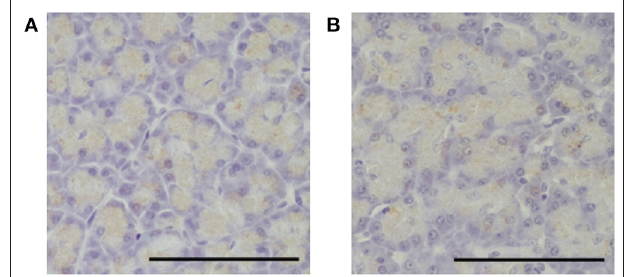
FIGURE 5 | Immunohistochemical image of the pancreas in the pimobendan group. A trypsinogen positive reaction of the zymogen granules was observed in the pancreatic acinar cells both before initiating rapid ventricular pacing (baseline) and at 4 weeks after initiating rapid ventricular pacing (4 weeks). (A) baseline. (B) 4 weeks. Bars = 100 µ